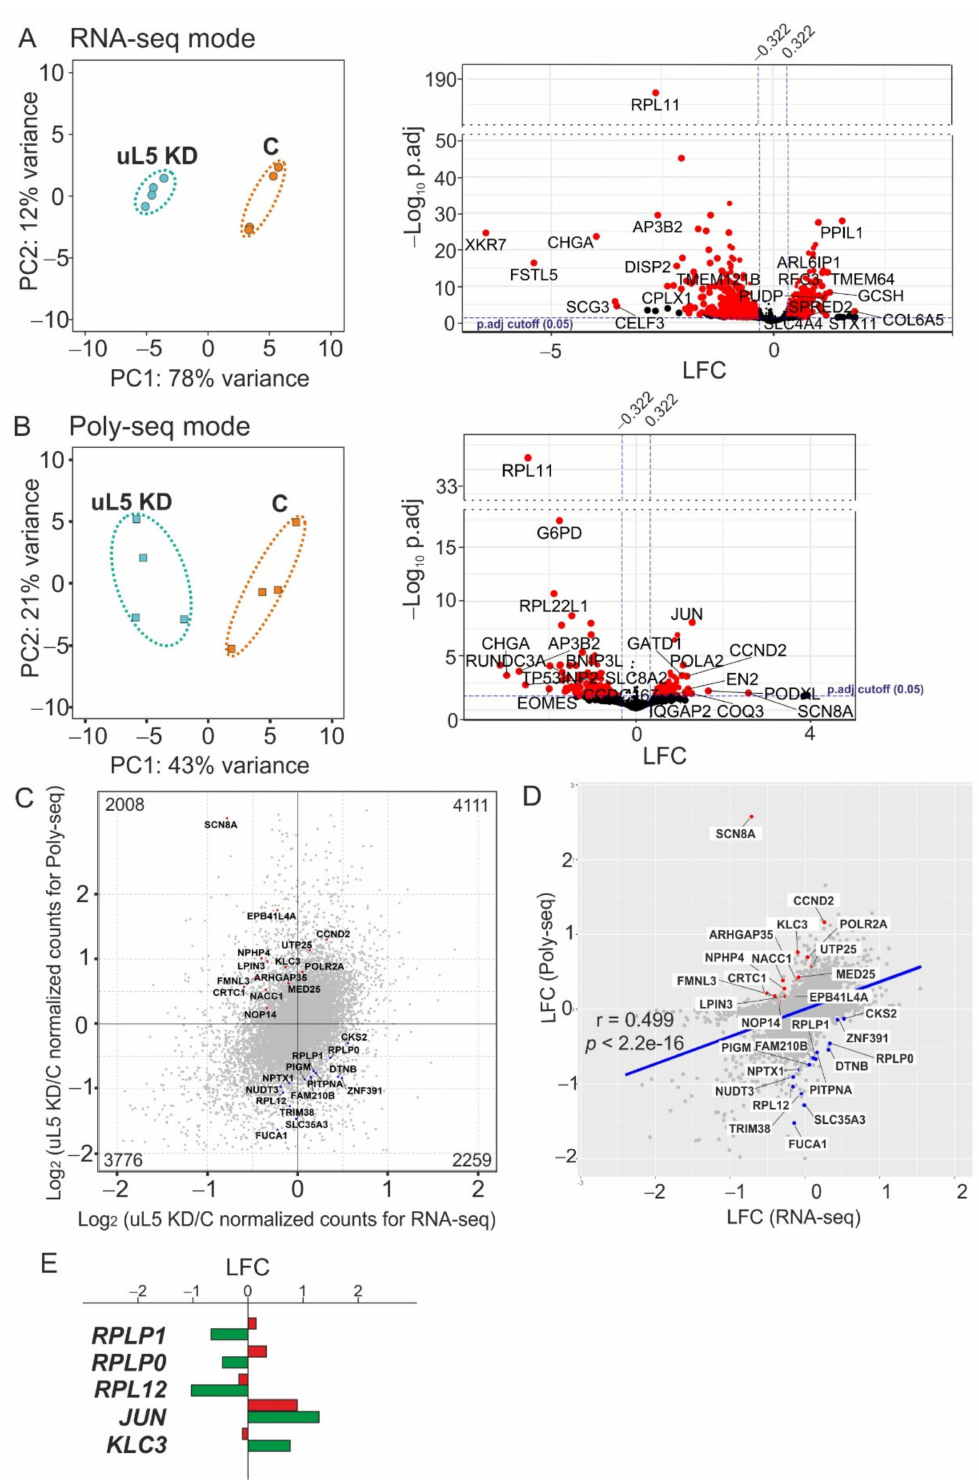
Figure 2. The general overview of data gained for uL5-deficient HEK293T cells in four biological replicates using the RNA-seq and polysome profiling followed by RNA-seq assays. ( A ) Analysis of RNA-seq data. Left panel, principal components analysis (PCA) data plot based on those obtained for total RNA samples from uL5 knocked down cells (uL5 KD) and control, non-targeting siRNA-treated cells ( C ). Right panel, a volcano plot exposing the results of the differential gene expression analysis using DESeq2, where each dot is a single gene plotted according to its shrunken Log2 Fold Change